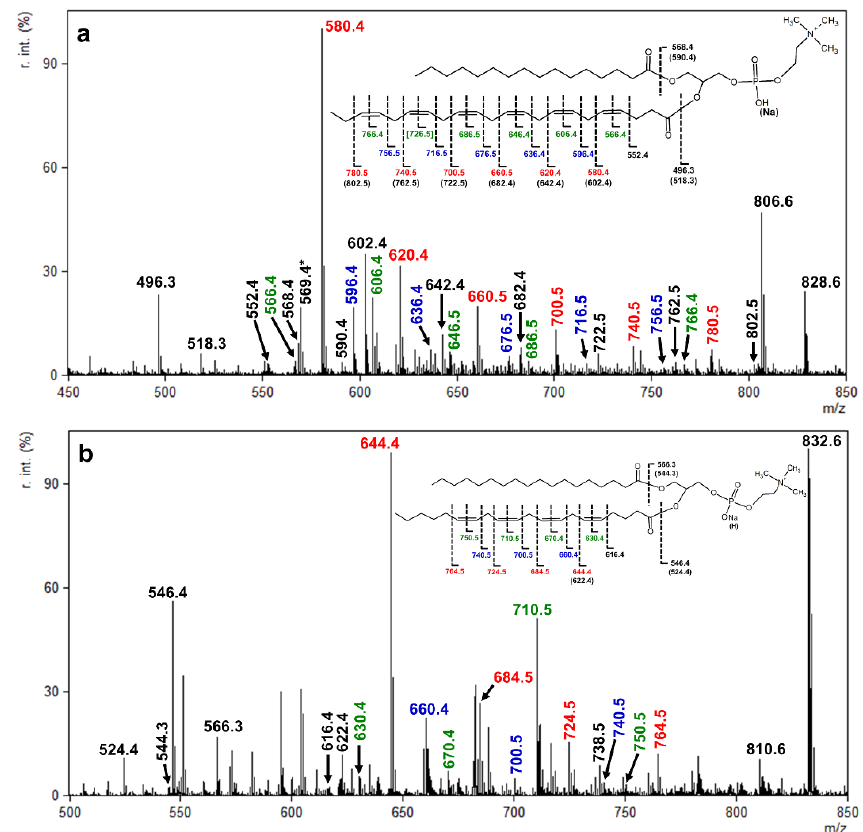
Figure 2. ISF-(in-source fragmentation)-MALDI/TOF spectra of PUFA-containing PCs. ( a ) ISF MALDI/TOF spectrum of PC 16:0/22:6. Protonated product ions from vinylic, double-bond, and allylic cleavages were marked in red, green, and blue, respectively, in the spectrum and the structure inset. Parenthesized m / z values in the structure inset denoted the sodiated form, and the bracketed m / z value denoted undetected species. ( b ) ISF MALDI/TOF spectrum of PC 18:0/20:4 with added Na + in preparation. Sodiated product ions from vinylic, double-bond, and allylic cleavages were marked in red, green, and blue, respectively, both in the spectrum and the structure inset. The m / z values of protonated ions were parenthesized in the structure inset. Reproduced (with slight modifications) from [56] with permission from Springer and courtesy by the authors. The asterisk denotes an ions stemming from the used DHB